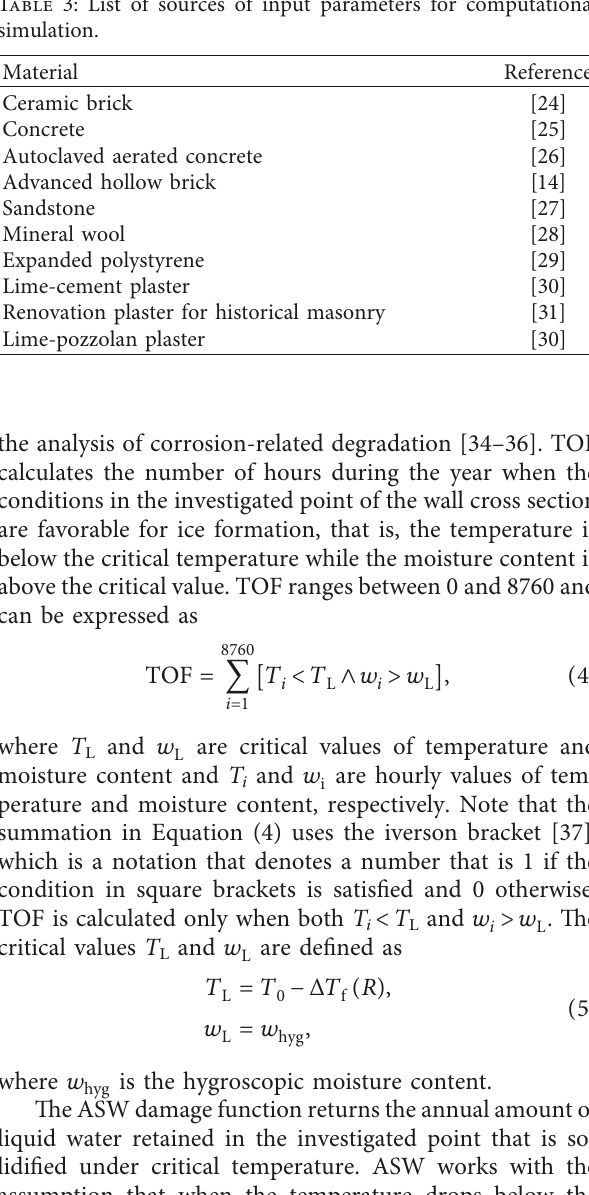
Table 3: List of sources of input parameters for